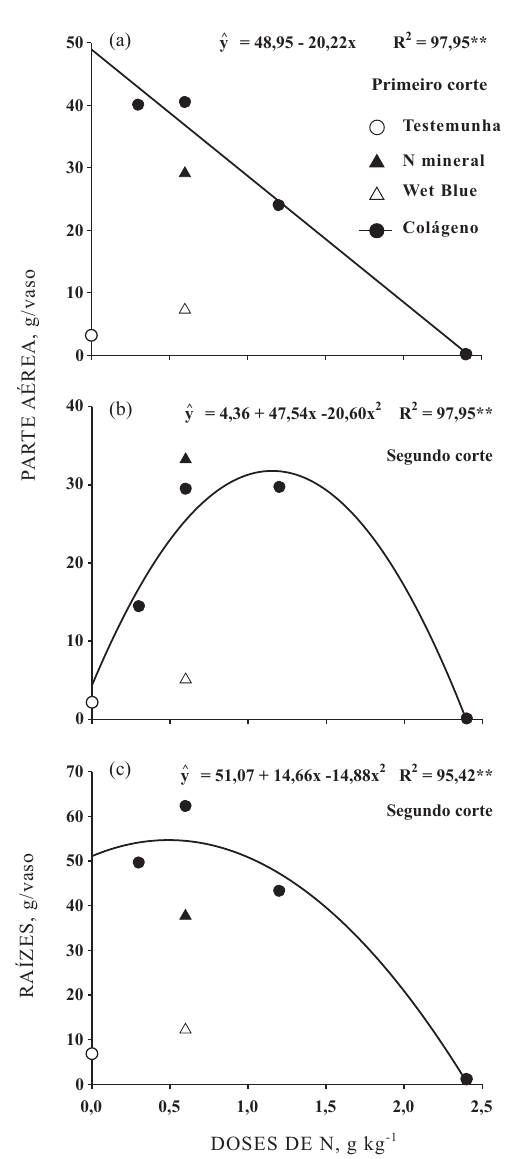
Figura 3. Produção de matéria seca da parte aérea por ocasião do primeiro (a) e segundo (b) corte e de raiz (c) em plantas de capim-elefante, com doses crescentes de colágeno e três tratamentos